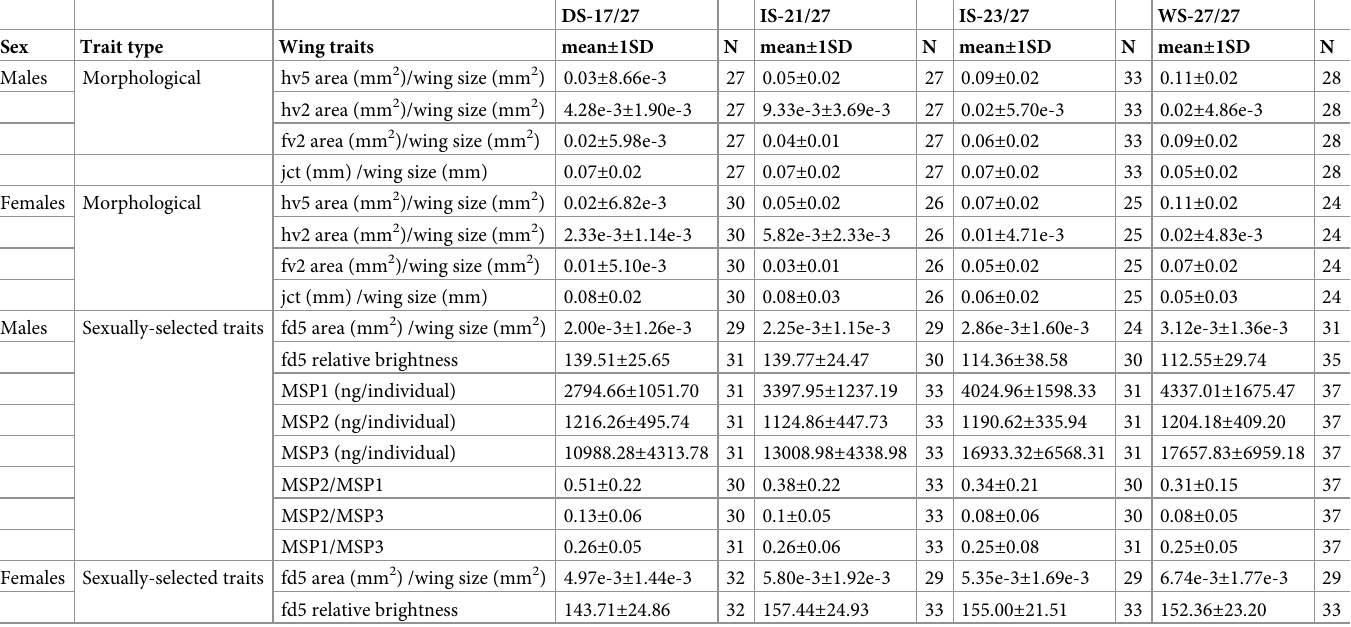
Table 1. Descriptive statistics of the wing traits per developmental temperature (17˚C, 21˚C, 23˚C, 27˚C) in experiment A.